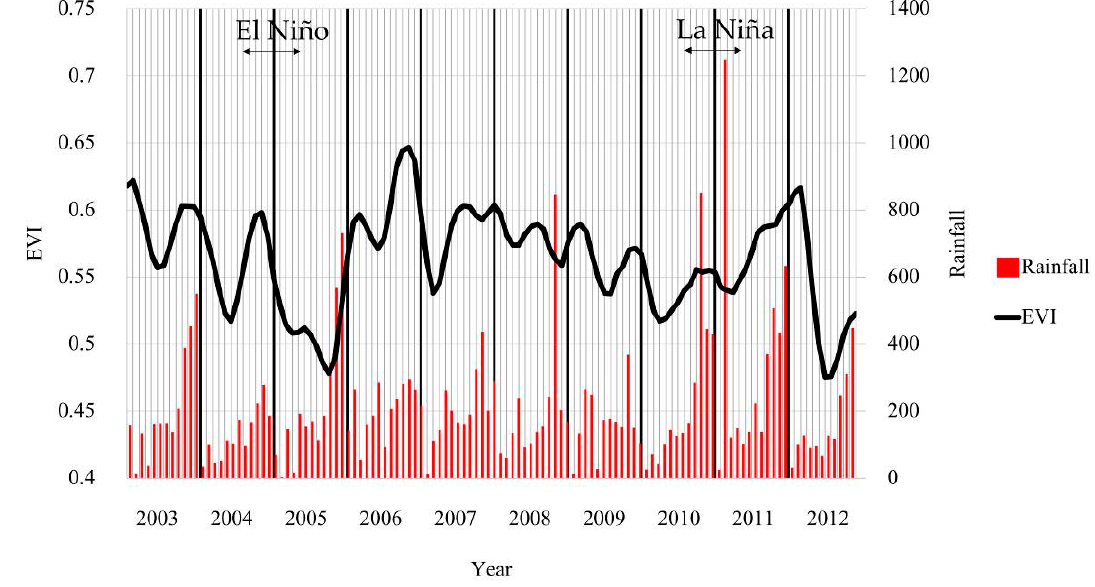
Figure 12. Time series of EVI and rainfall at Nakhon Si Thammarat province site over a time period encompassing both El Niño and La Niña phenomena [125].